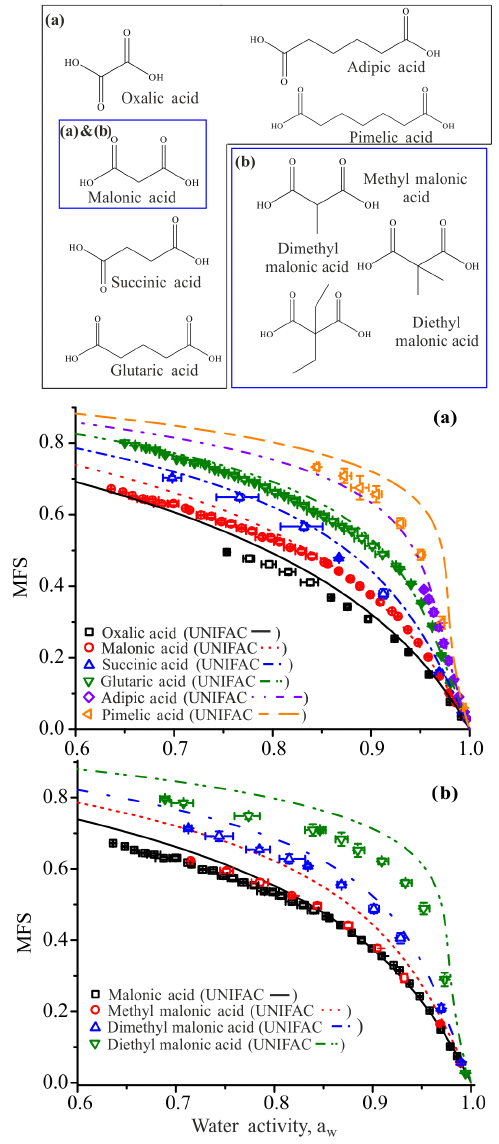
Figure 2. Equilibrium hygroscopic growth curves are shown in (a) for the homologous series of straight chain dicarboxylic acids and in (b) for dicarboxylic acids with a malonic acid back- bone and increasing methyl substitution. UNIFAC prediction using